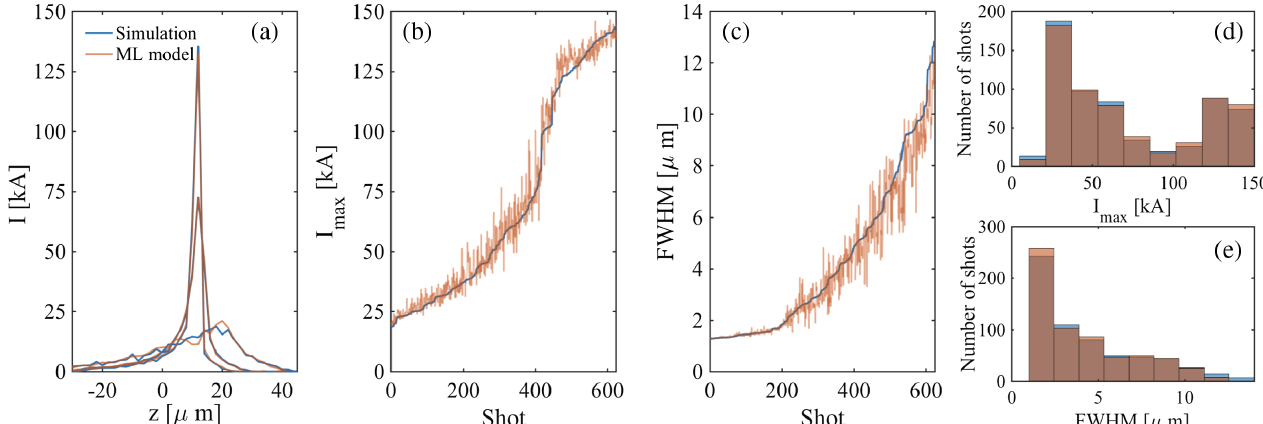
FIG. 2. (a) Examples of reconstructed current profiles from a ML model compared to the true data from simulation at the exit of the FACET-II accelerator. The profiles are taken from a set of 625 test cases which the NN is not trained on. (b) – (e) Sorted plots of the peak current and full width half maximum and histograms of the distributions for the ML prediction and the simulation, showing good agreement between the ML model and simulation